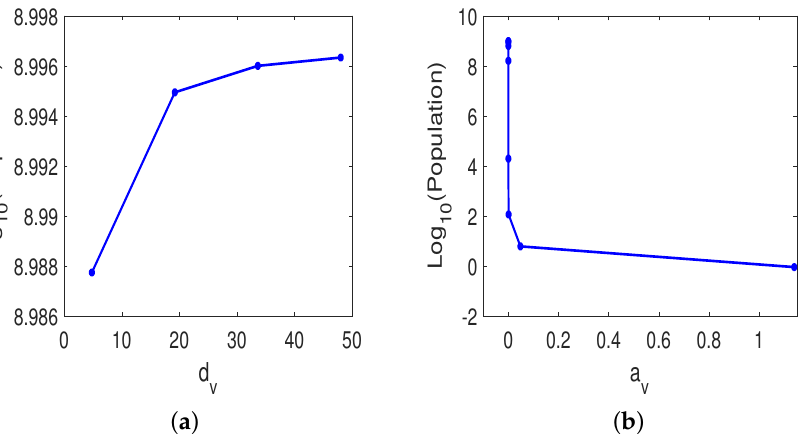
Figure 9. Susceptible tumor size in oncolytic virus sensitivity analysis. The tumor size is plotted against ( a ) d v , the killing rate of virions by innate immune cells; ( b ) a v , the proliferation rate of immune cells induced by oncolytic